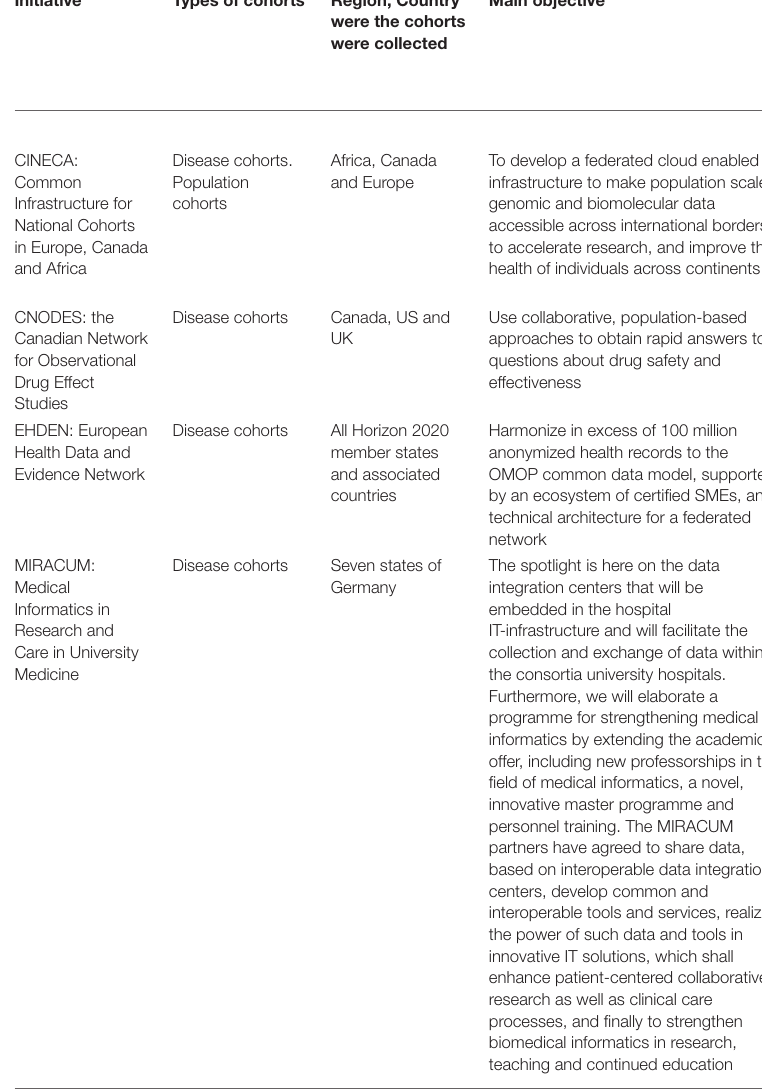
TABLE 1 | Initiatives that harmonize patient cohorts ordered by different categories of diseases (selected information).